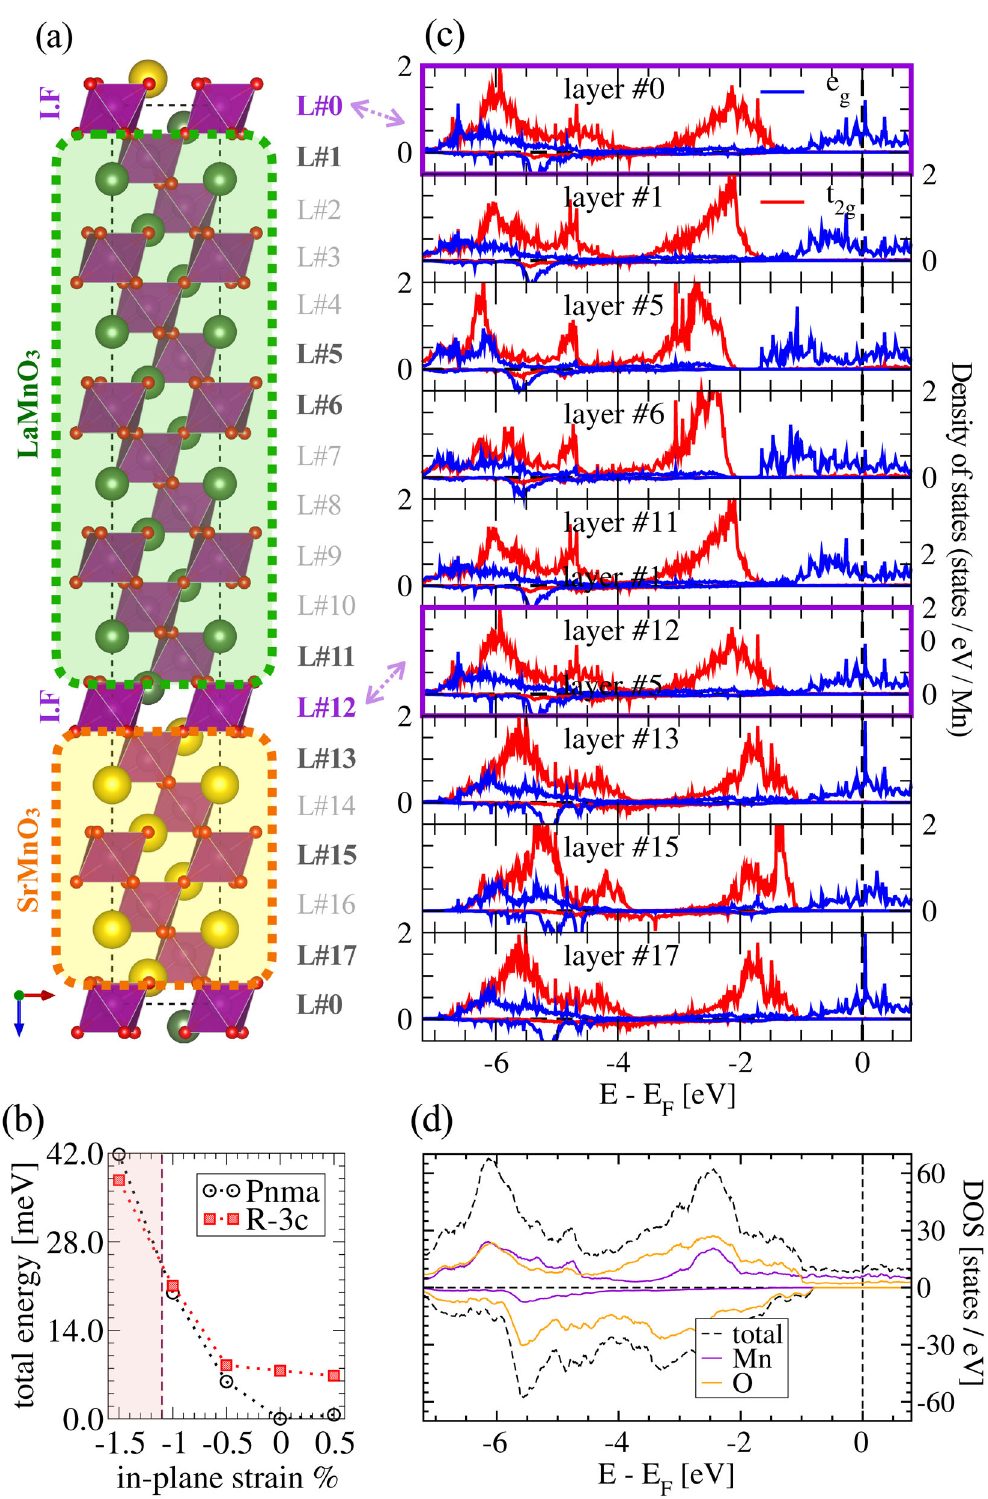
Fig. 1 Overview of the superlattice and its properties. a Crystal structure of the superlattice. The interfacial layers are #0 and #12. b Curve total energy vs strain for FM solutions with a − a − c + (black) and a − a − a − (red); `zero' strain means that the pseudo-cubic lattice constant is 3.860 Å . c Projected DOS for Mn- t 2 g and Mn- e g states for selected layers; additional information, covering all Mn and O layers, is provided in the Supplemental Material. d Total, Mn- d projected and O- p projected DOS for the FM